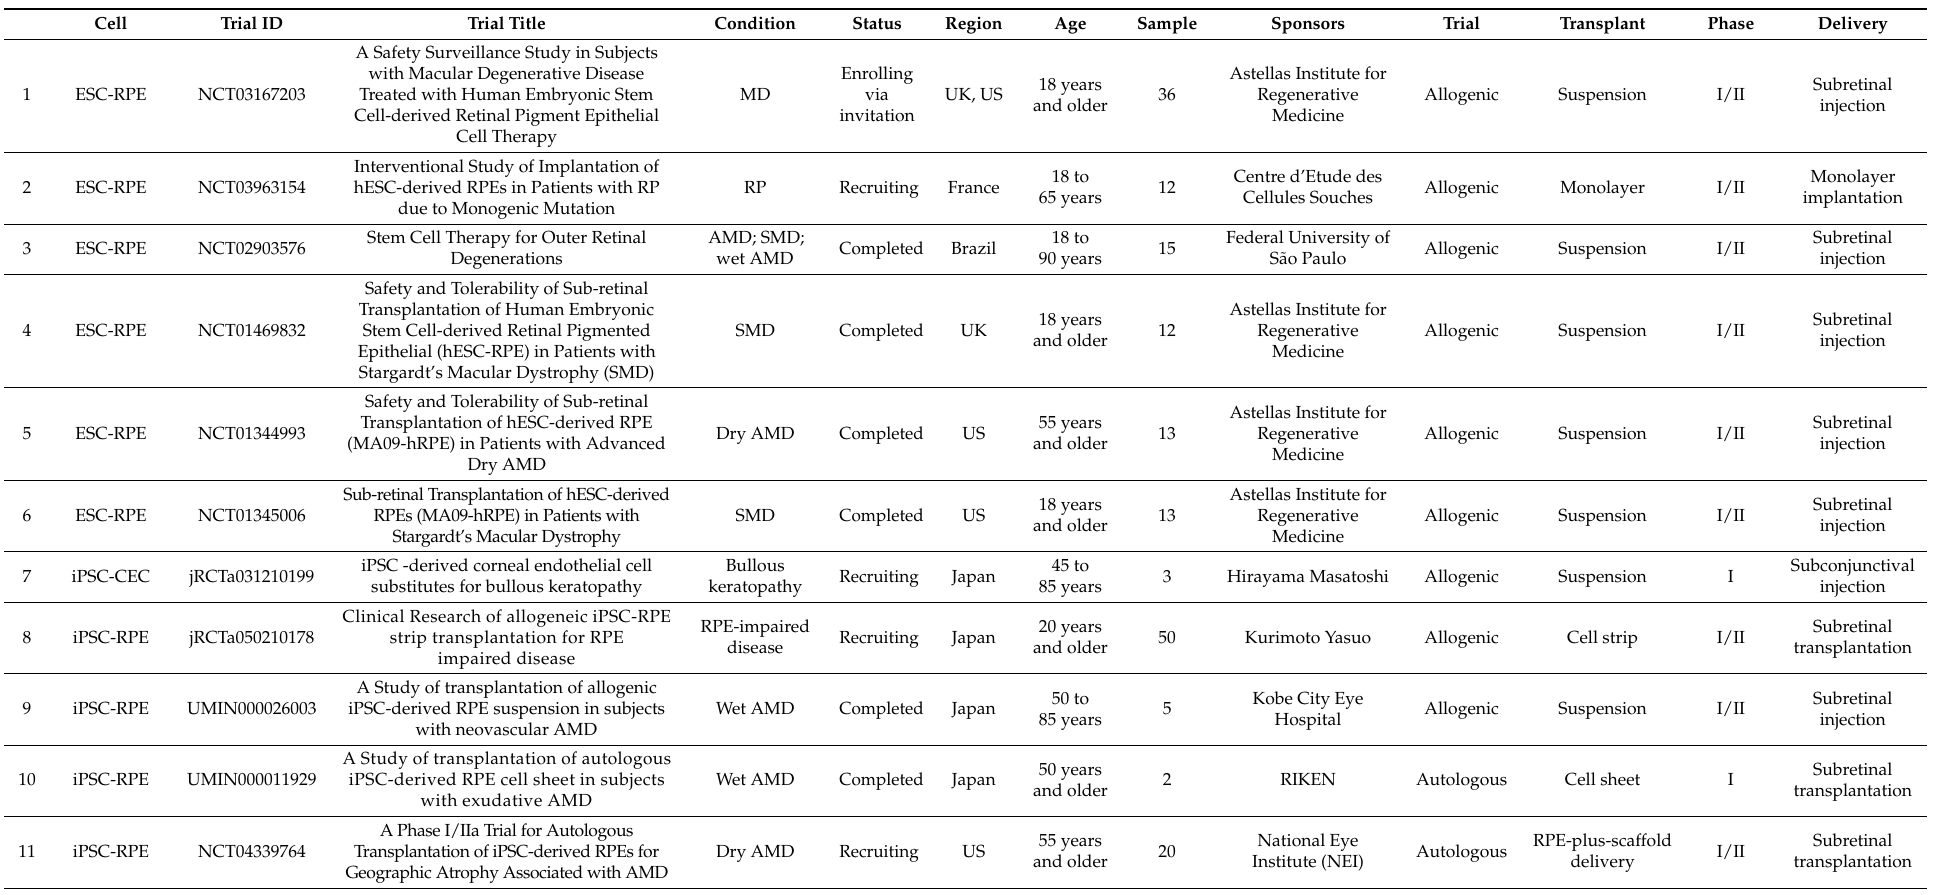
Table 2. Interventional clinical trials of ESC- and iPSC-based studies in retinal therapy with recruiting, enrolling via invitation, and completed